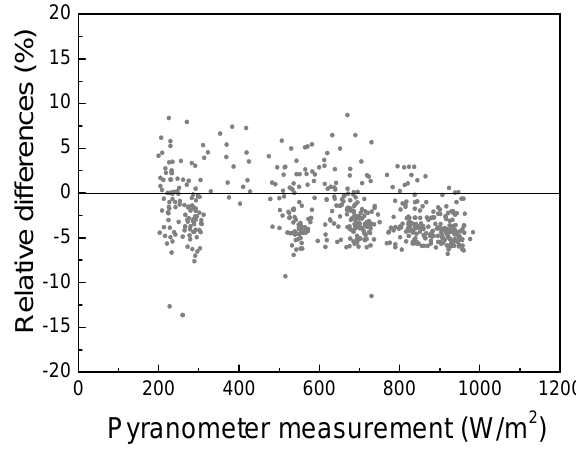
Fig. 5. Relative differences between modeled (SBDART) and ex- perimental (CM-11) downward irradiances against experimental